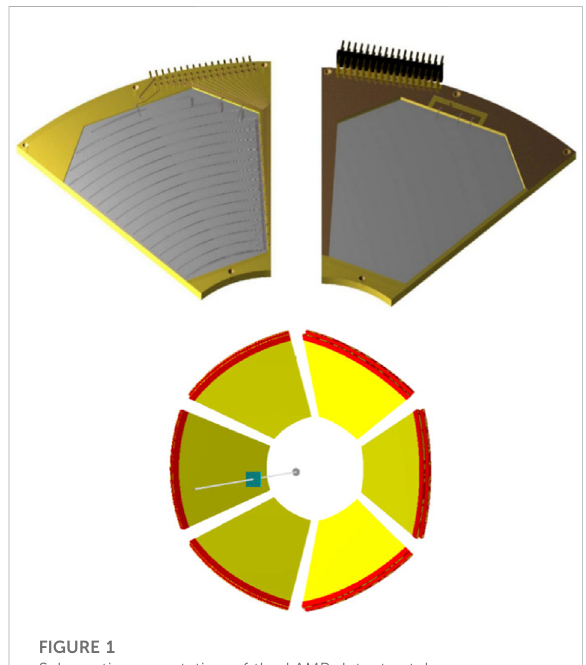
FIGURE 1 Schematic presentation of the LAMP detector telescope setup used in the experiment.